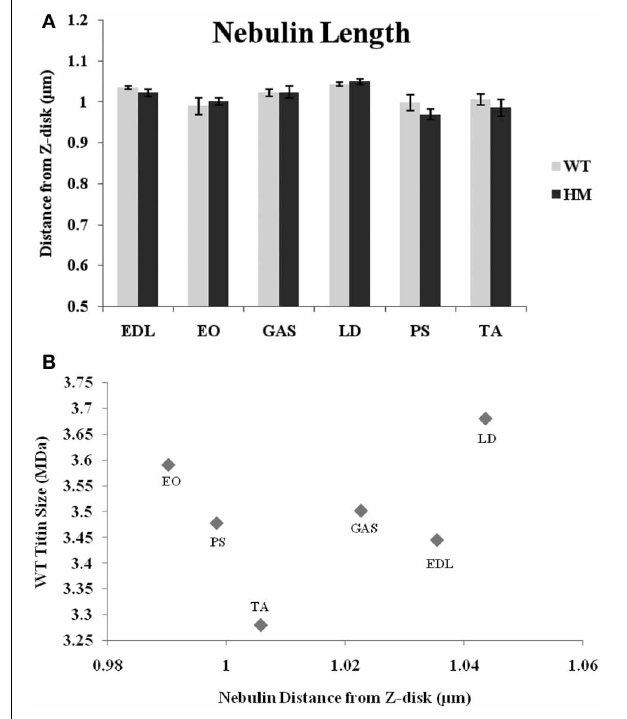
FIGURE 3 | (A) Phalloidin staining determination of thin filament lengths in different muscles and rat genotypes. EDL, Extensor digitorum longus; EO, external oblique; GAS, gastrocnemius; LD, longissimus dorsi; PS, psoas major; TA, tibialis anterior; WT, wild type; HM, homozygous mutant. (B) Relationship between titin size and phalloidin estimated thin filament length.